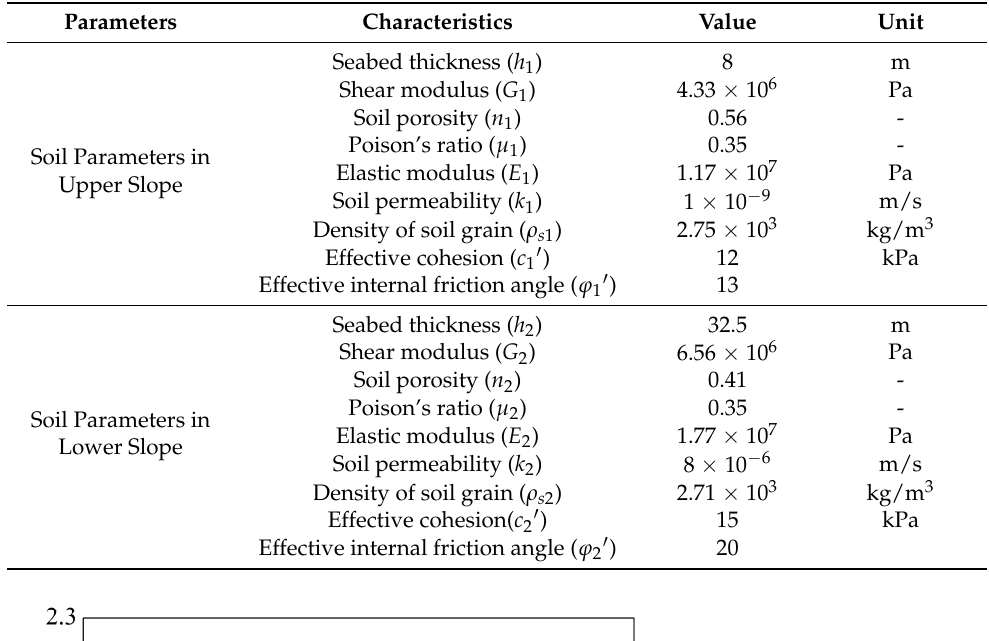
Table 2. Input soil parameters of the two-stage slope.